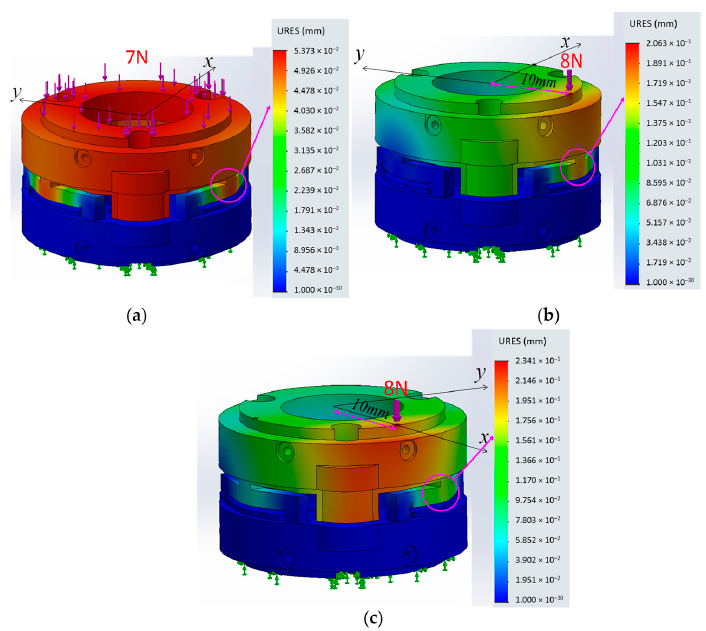
Figure 9. The FEM Simulation (the simulations performed using Solidworks FEM Simulation tool): ( a ) when F z is applied on the upper plate, the simply-supported beam deflects around δ = 0.05 mm; ( b ) when F z and M x are applied on the upper plate, the simply-supported beam deflects around δ = 0.15 mm; and ( c ) when F z and M y are applied on the upper plate, the simply-supported beam deflects around δ = 0.15 mm.